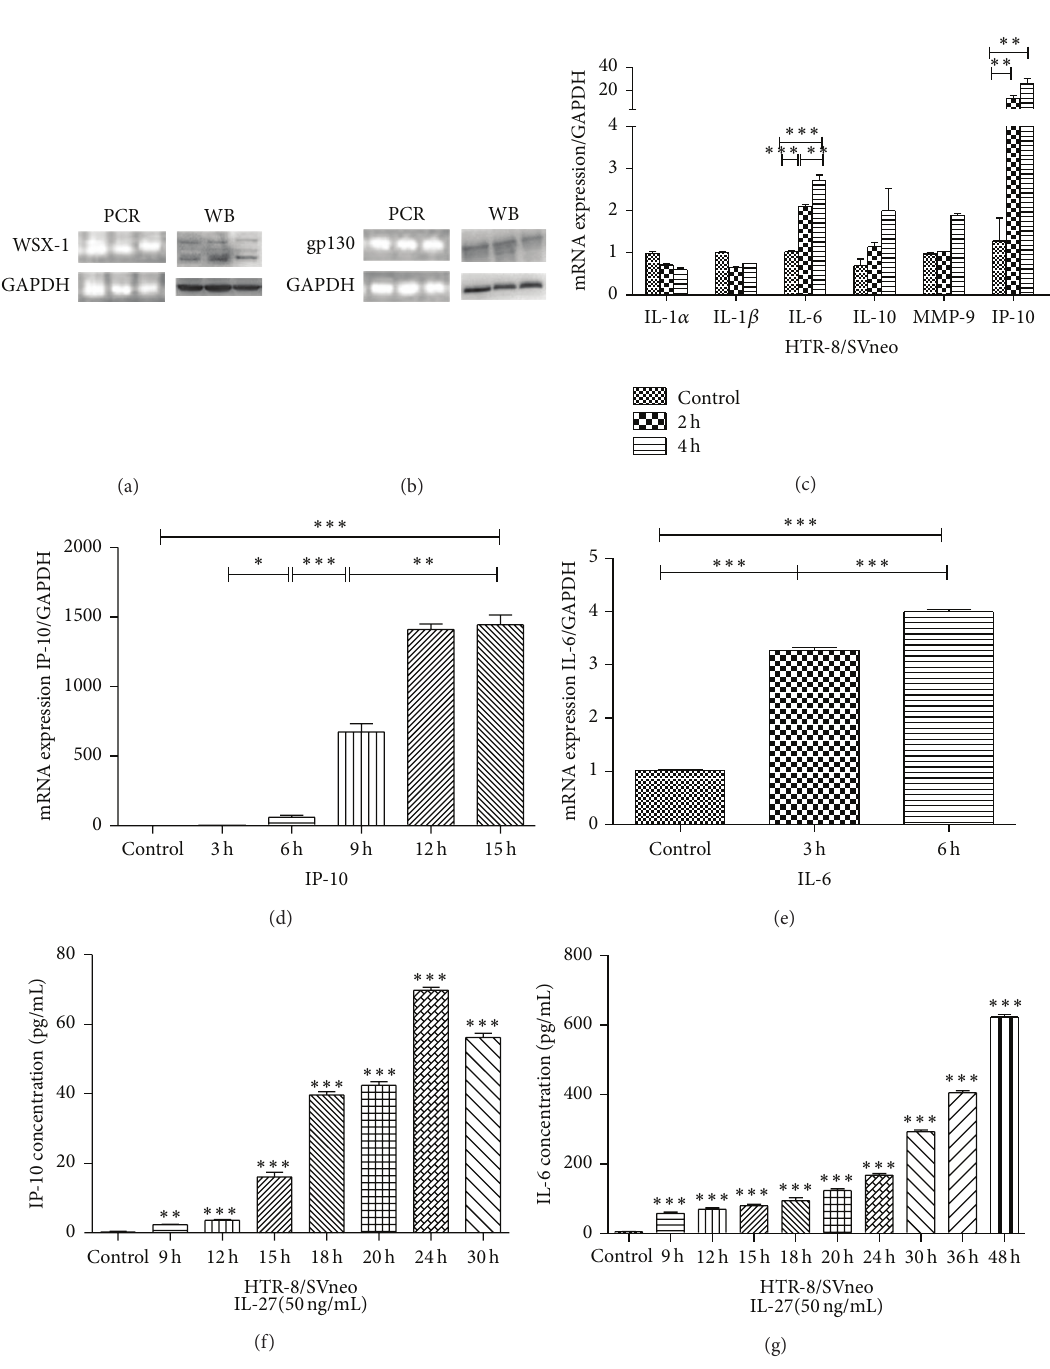
Figure 3: IL-27 and IL-27 receptor was expressed in HTR-8/SVneo cells and it upregulated CXCL10 and IL-6. (a) RNA and protein expression for WSX-1. (b) RNA and protein expression of gp130. From the left to the right lane, respectively, are Hct116 (human colon cancer cells), Skov3 (ovarian carcinoma cells), and HTR-8/SVneo. Hct116 and Skov3 were used as control. GAPDH was used as protein control to ensure an equal amount of loaded protein. (c) Effects of IL-27 (50 ng/mL) on the mRNA expression of inflammatory mediators. Kinetic gene expressed of CXCL10 (d) and IL-6 (e) in HTR-8/SVneo cells under stimulated with IL-27. ∗ 𝑃 < 0.05 , ∗∗ 𝑃 < 0.01 , and ∗∗∗ 𝑃 < 0.001 when compared between groups denoted by horizontal lines ( 𝑛 = 3 ). (f) CXCL10 protein levels after the stimulation of IL-27 (0–50ng/mL) in cell supernatant of HTR-8/SVneo (0–30h). (g) IL-6 protein expression after the stimulation of IL-27 (0–50 ng/mL) in cell supernatant of HTR-8/SVneo (0– 48 h). ∗ 𝑃 < 0.05 , ∗∗ 𝑃 < 0.01 , and ∗∗∗ 𝑃 < 0.001 when comparing the level at the starting time point. All experiments were performed in three independent